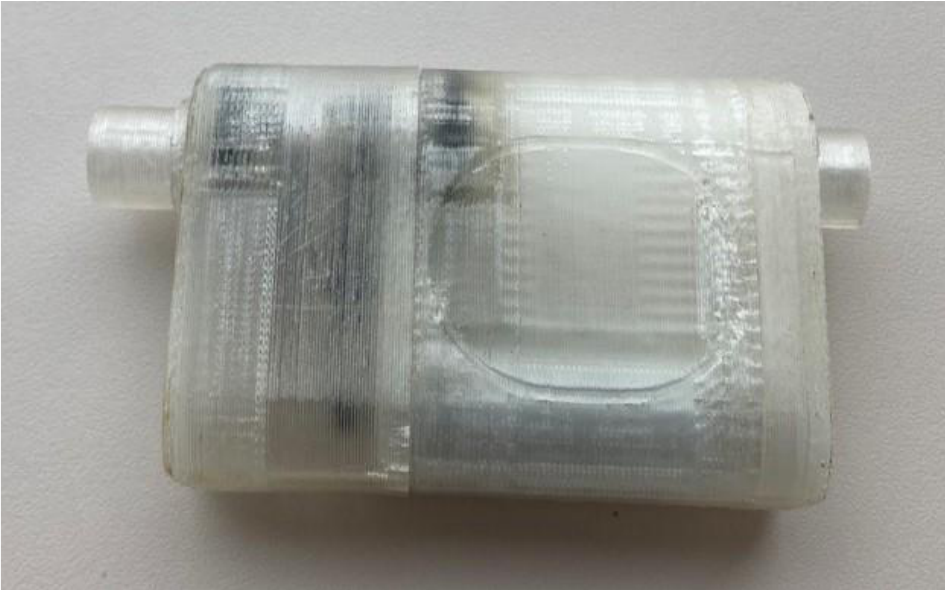
Figure 7. Prototype of the device made using fused deposition modeling technique .